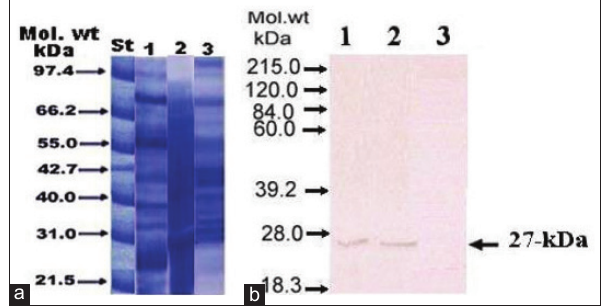
Figure-1: (a) Sodium dodecyl sulfate-polyacrylamide gel electrophoresis. (b) Western blotting for different antigenic sources of Fasciola gigantica and Paramphistomum cervi using immunoglobulin G rabbit anti- Fasciola antibody. Lane 1: F. gigantica adult worm antigen preparation; lane 2: Excretory/secretory antigen products from F. gigantica ; lane 3: P. cervi antigenic